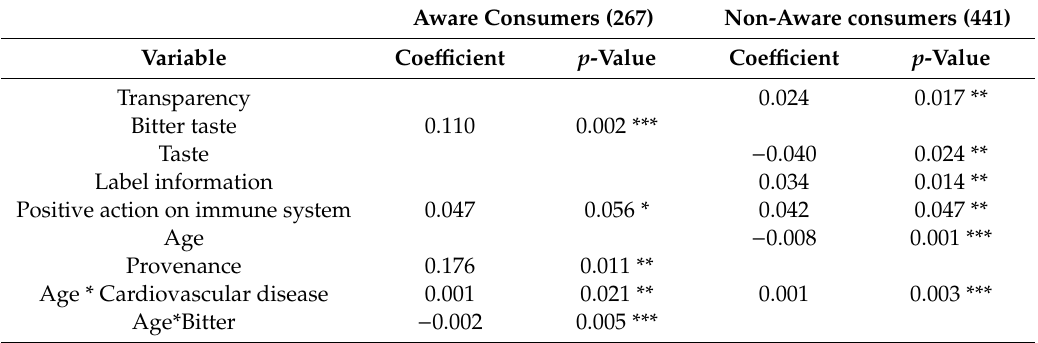
Table7. Marginale ff ectsofattributesa ff ectingtheconsumptionofoliveoilwithhighantioxidantcontent. Aware Consumers (267) Non-Aware consumers